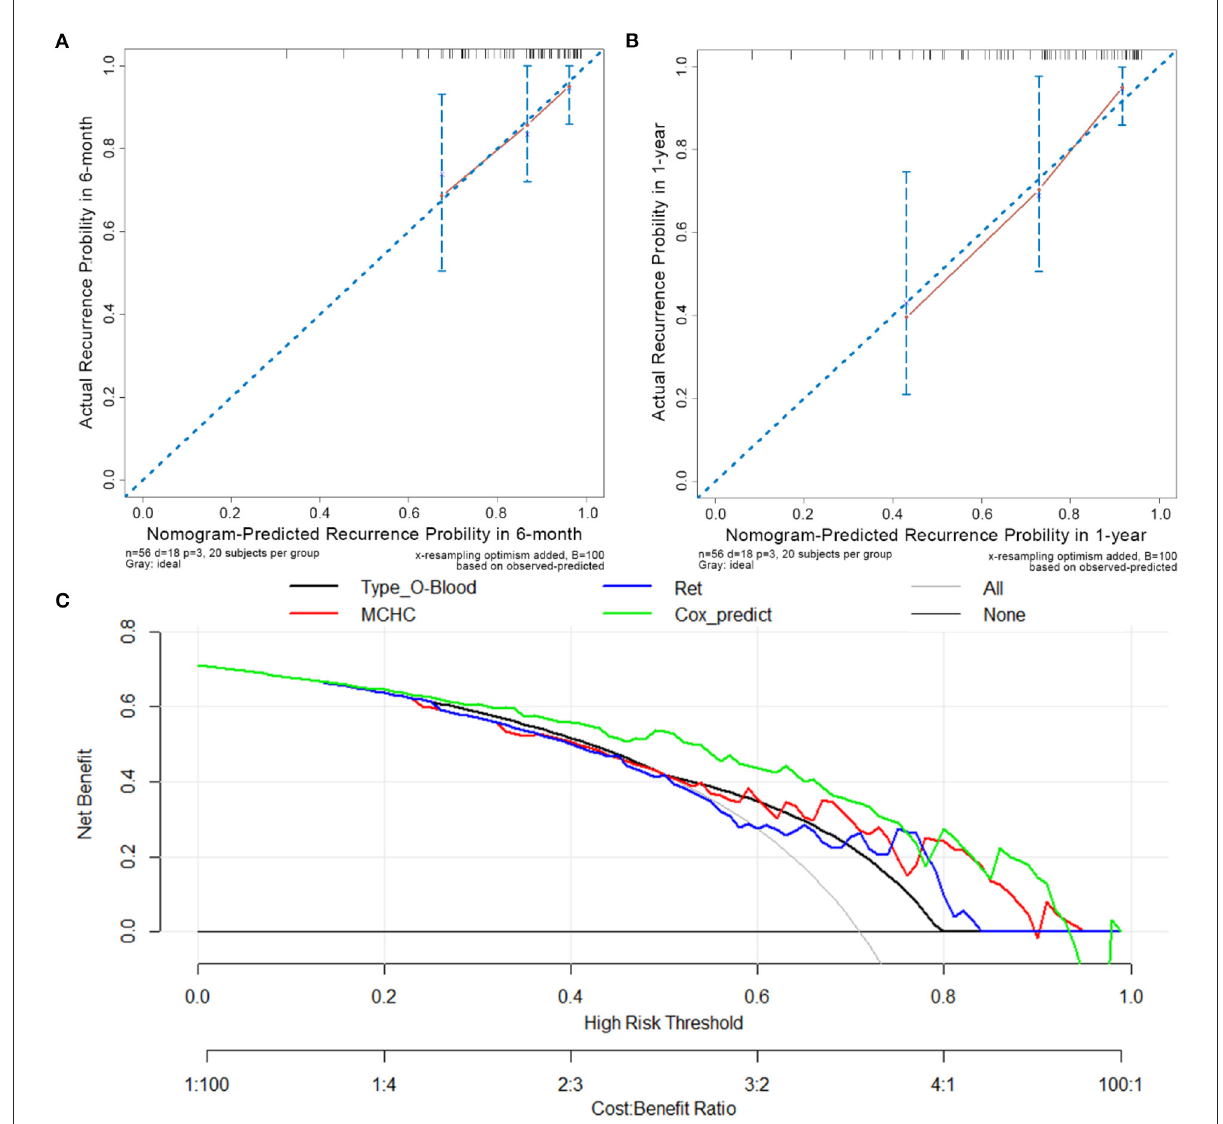
FIGURE5 Calibration curves and decision-curve analysis (DCA) of the Cox regression predictive model. (A) The calibration curve in 6 months after the initial diagnosis. (B) The calibration curve in 1-year after initial diagnosis. (C) The DCA of Cox regression predictive model and other risk indicators; MCHC, mean corpuscular hemoglobin concentration; Ret, reticulocyte count; Cox_predict, Cox regression predictive